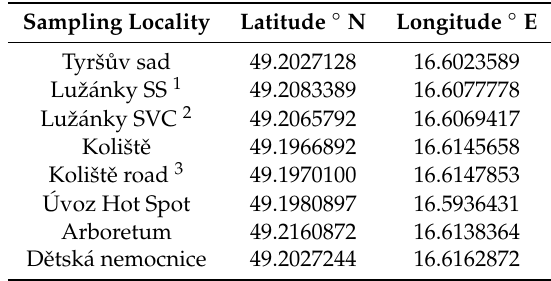
Table 1. The geographic coordinates of the measured localities.